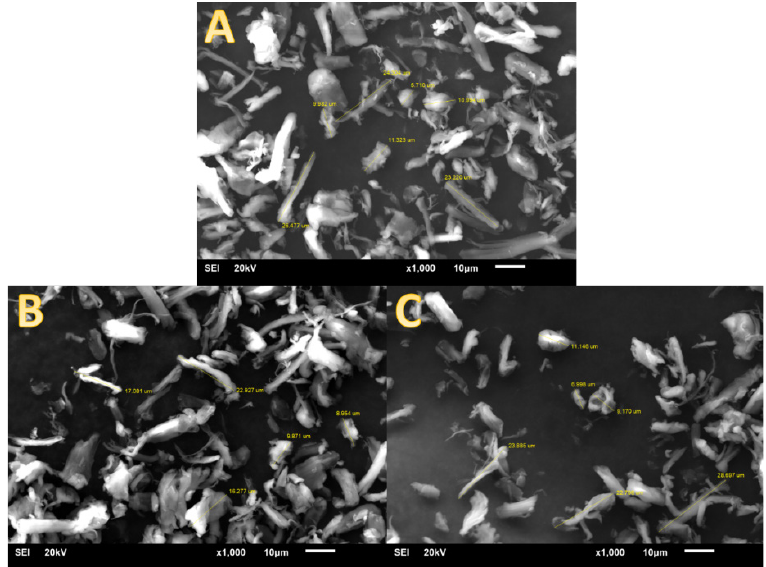
Figure 5. SEM images of ( A ) pure cellulose, cellulose modified with ( B ) OTES and ( C ) MPMS, at magnification 1000×.